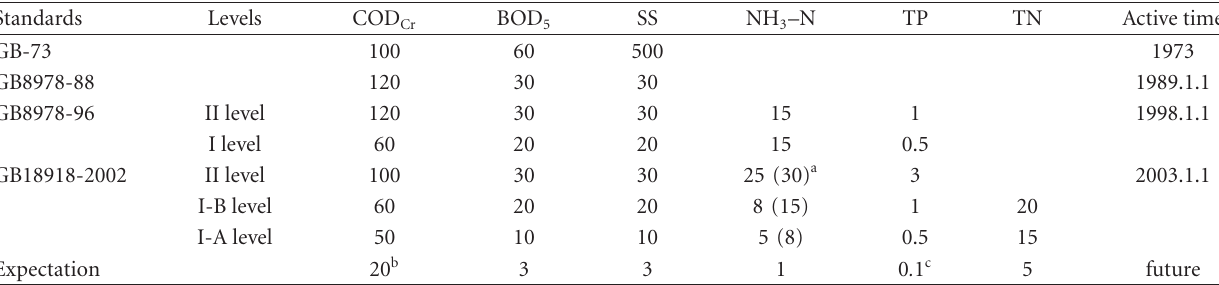
Table 3: National discharge criteria of municipal WWTPs in